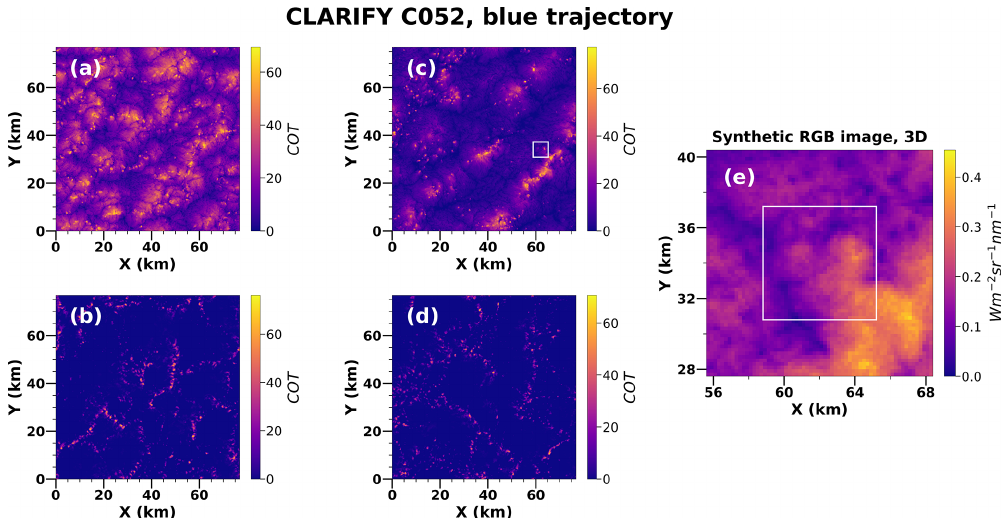
Figure 4. (a)–(d) Lagrangian LES COT fields (600nm) from the Atlantic taken during the CLARIFY campaign simulating a closed-cell stratocumulus cloud deck transitioning to a broken open-cell cloud deck over a 78km × 78km domain. (e) 3D synthetic radiance calculations (red = 600nm) shown for the 6.4km × 6.4km highlighted white box sub-domain in (c)